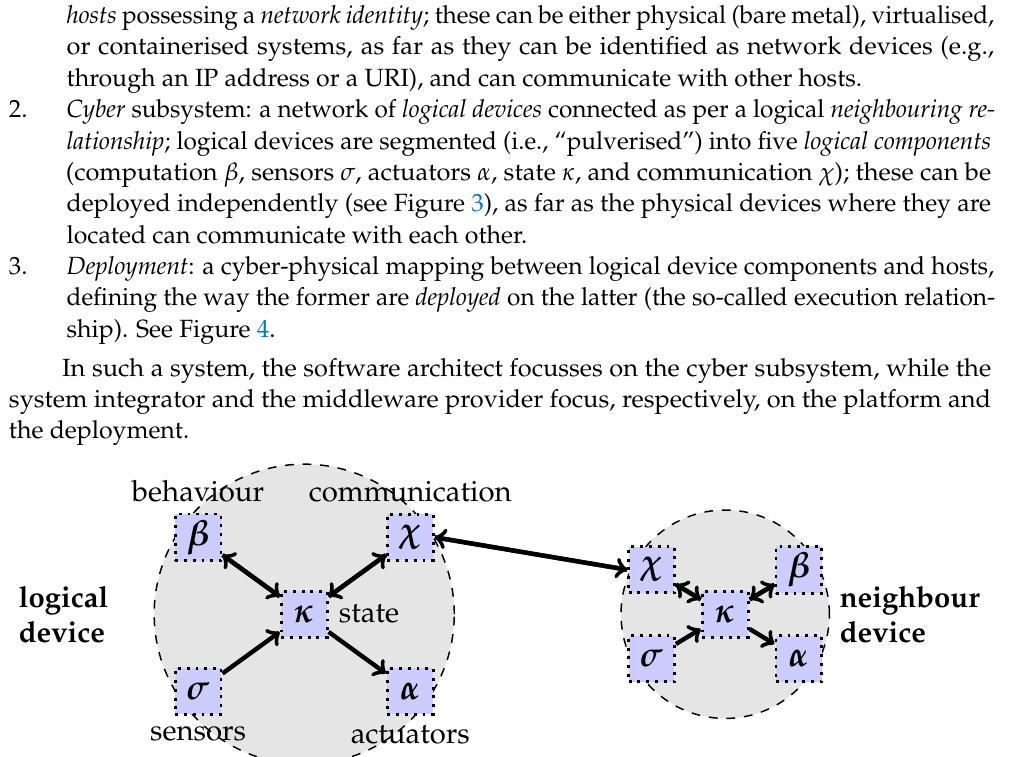
Figure 3. Two neighbouring logical devices, depicted as pulverised into their logical components. Arrows mark directional data flows among pulverised components. The neighbour relationship is reified by the existing connection between the two communication components of the devices.